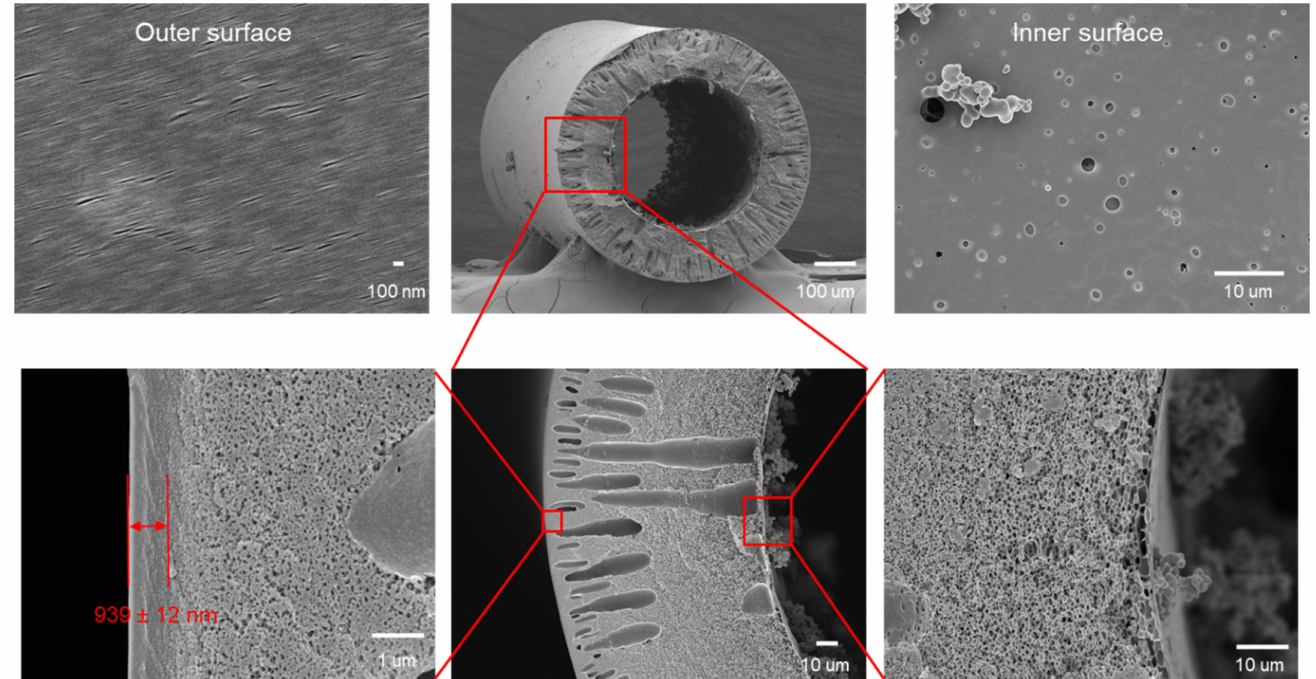
Figure 5. Surface and cross-sectional morphologies of a kind of ISA HF OSN membrane with a 939 nm thickness dense selective layer on its outer layer. Reprinted with permission from Ref. [31]. Copyright 2021,